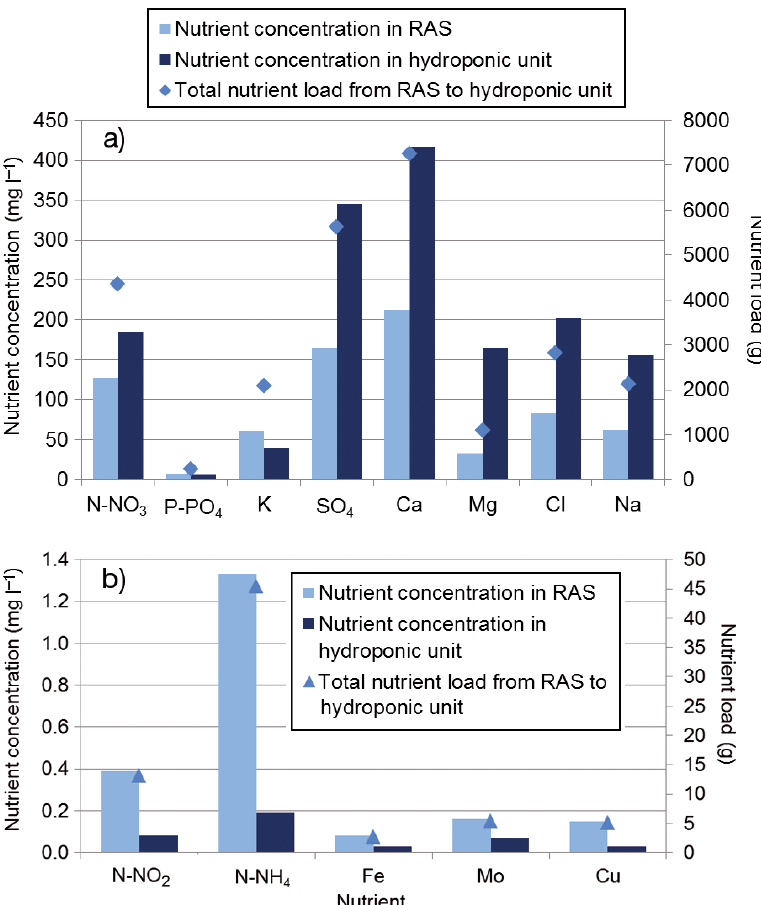
Fig. 7. Means of macro- and micronutrients (cf. Table 1) in the recirculating aquaculture system (RAS) and the hydroponic unit and total load of macro- and micronutrients launched from aquaculture RAS into the nutrient film technique (NFT) hydroponic unit of ASTAF-PRO during the testing period from 6 March to 26 November 2009. The total volume of fish water trans- ferred into the hydroponic component was 34.06 m 3 . Note the different scale between panels